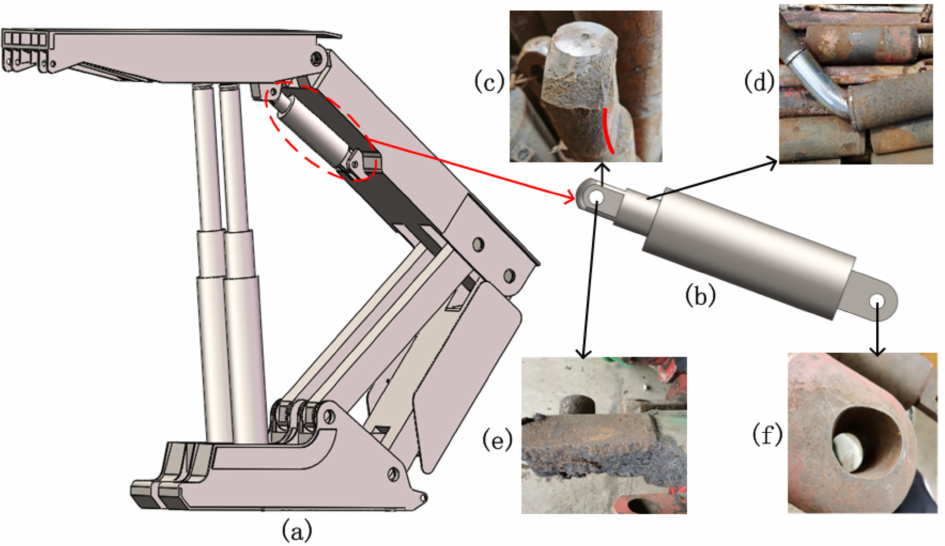
Figure 1. Actual failure mode: ( a ) hydraulic support; ( b ) the balance jack; ( c ) damage at the connection of piston rod; ( d ) piston rod bending; ( e ) the coupling pin shaft is broken; ( f ) pin hole